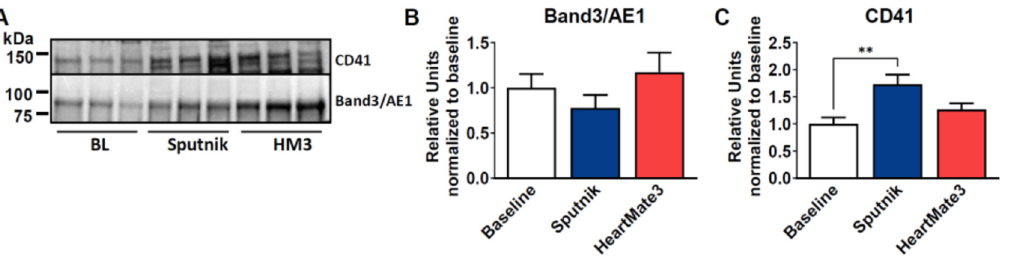
Figure 8. ( A ) Representative Western blot images of common EVs markers in EVs isolated at baseline and after 6h of circulation using the Sputnik or HeartMate 3 pump. ( B , C ) Western blot bands were quantified and normalized to the corresponding total protein amount visualized in the acrylamide gels by stain-free technology and then compared to baseline. Data represent means ± SEM of six independent samples. Significance: ** p < 0.01.